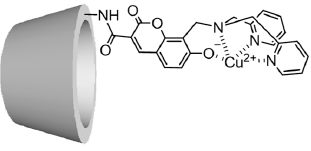
Figure 1. Structure of dipicolylamine-modified cyclodextrins (CyDs).